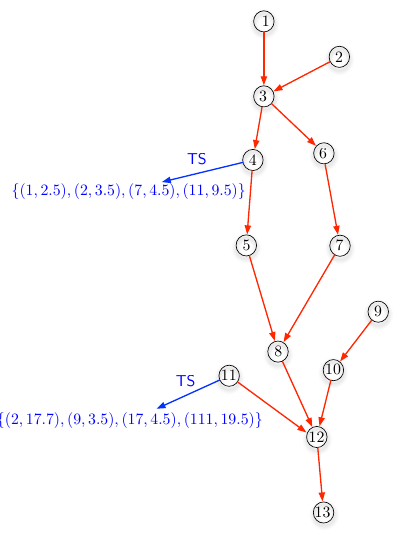
Figure 1. A transportation network shown as a directed graph in which the flowsTo relation is depicted by the red arrows. In this example, nodes 4 and 11 are sensors and they are shown together with the time series attached to them (shown by the blue TS